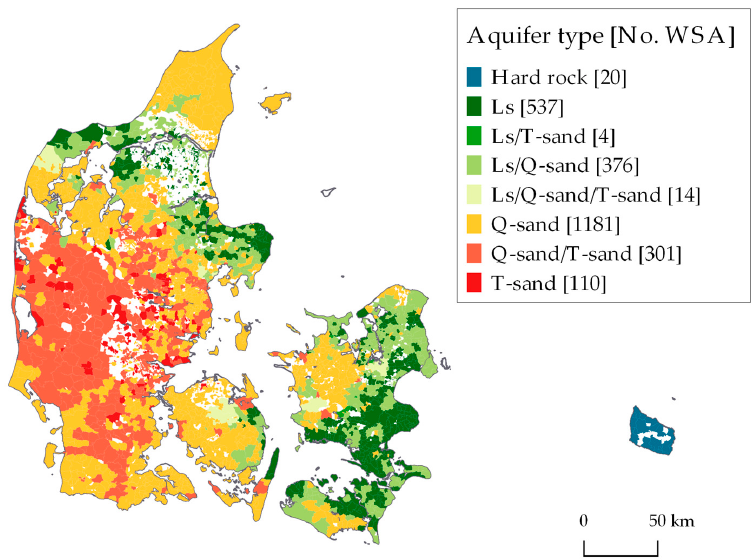
Figure 4. WSAs linked to main aquifer types in Denmark average 1980–2017. Ls = Tertiary/Cretaceous limestone, T-sand = Tertiary sand, Q-sand = Quaternary sand. Table 3. Comparison of mean drinking water concentrations of Na, K, Mg and Ca between the four main aquifer